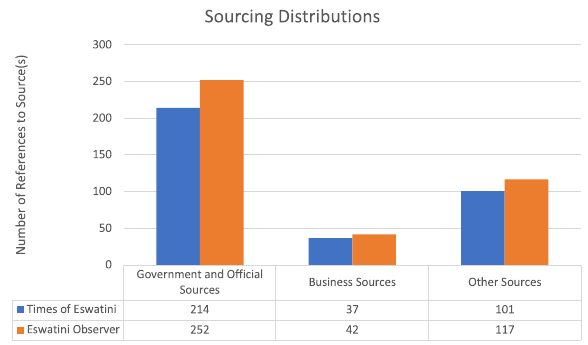
Fig. 4 Sourcing patterns and distribution. The fi gure shows that the Eswatini Observer largely used government and of fi cial sources in its construction of coronavirus stories. On the other hand, the Times of Eswatini relied on government and of fi cial sources but much less when compared with the Eswatini Observer